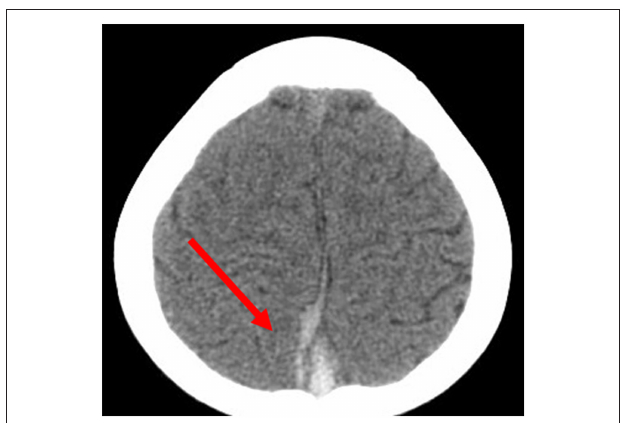
FIGURE 1 | A CT scan before treatment showing a high-density shadow in the superior sagittal sinus.